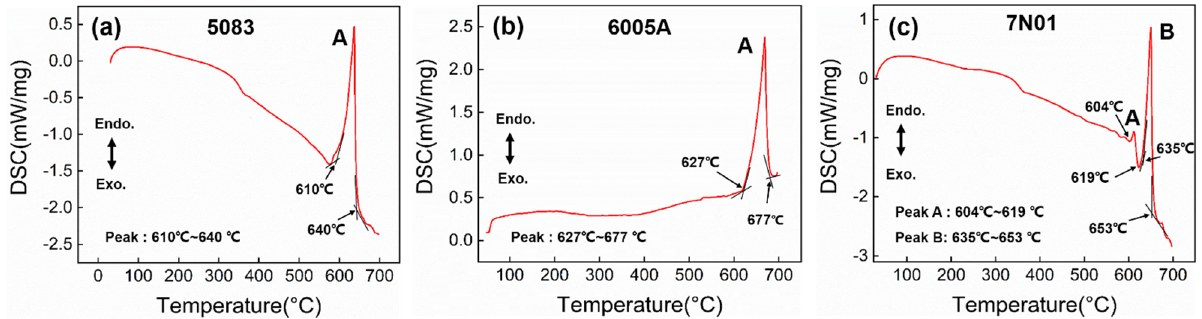
Figure 6. The differential scanning calorimetry (DSC) curves of different aluminum alloy joints: ( a ) 5083; ( b ) 6005A; ( c ) 7N01.